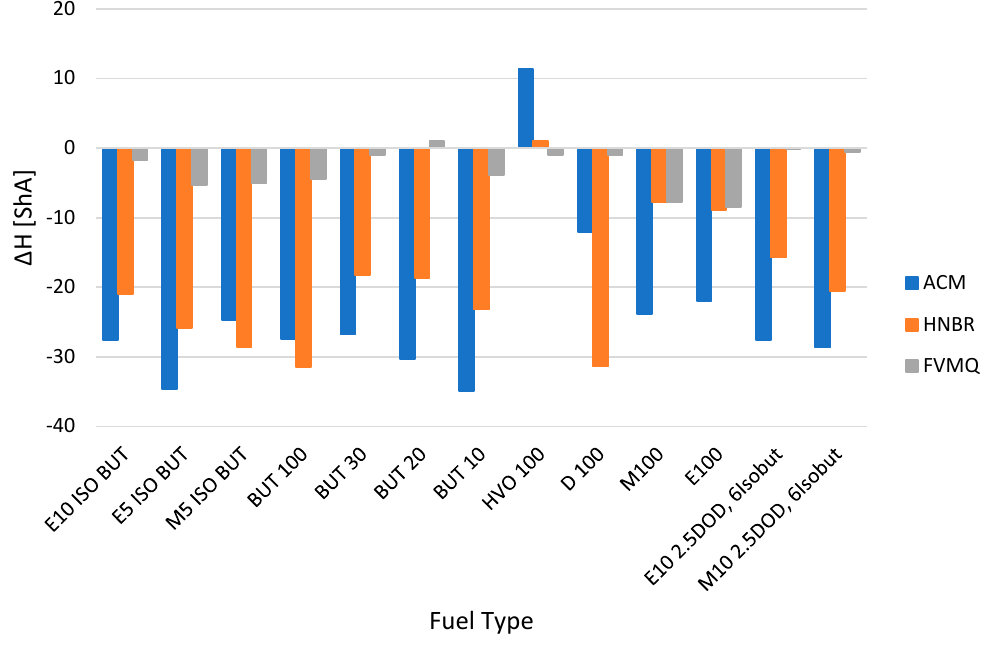
Figure 3. Change in hardness Shore A ∆ H for different elastomer O-rings and fuels after exposure for a time interval of 2998 h.